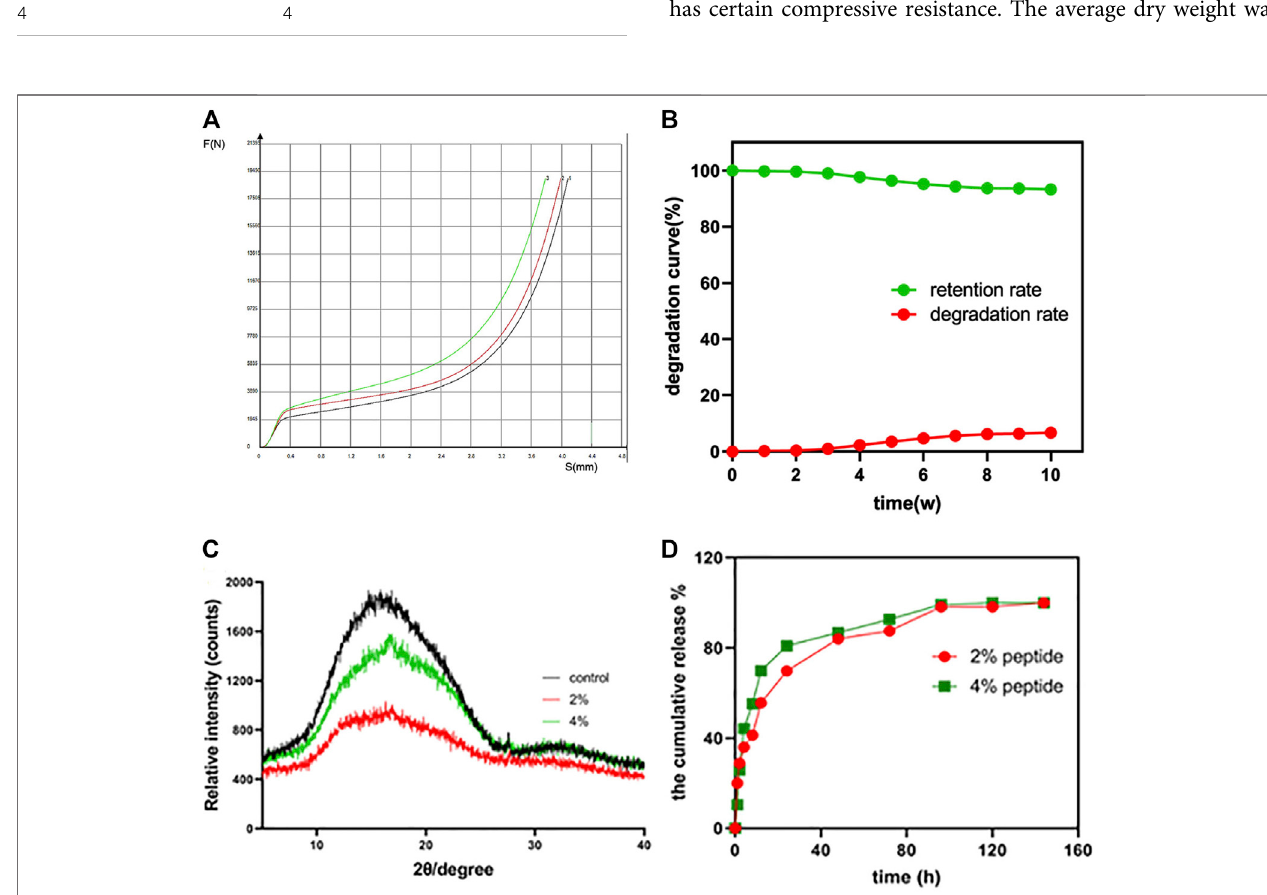
FIGURE 2 | (A) The compressive strength (force-displacement curve) of the PLGA scaffold ( n = 3). (B) The in vitro degradation behavior of the PLGA scaffold. (C) XRD patterns of the raw PLGA scaffold and the peptide-loaded scaffolds; (D) the in vitro peptide release pro fi le of the 2% and 4% peptide-loaded PLGA scaffolds.